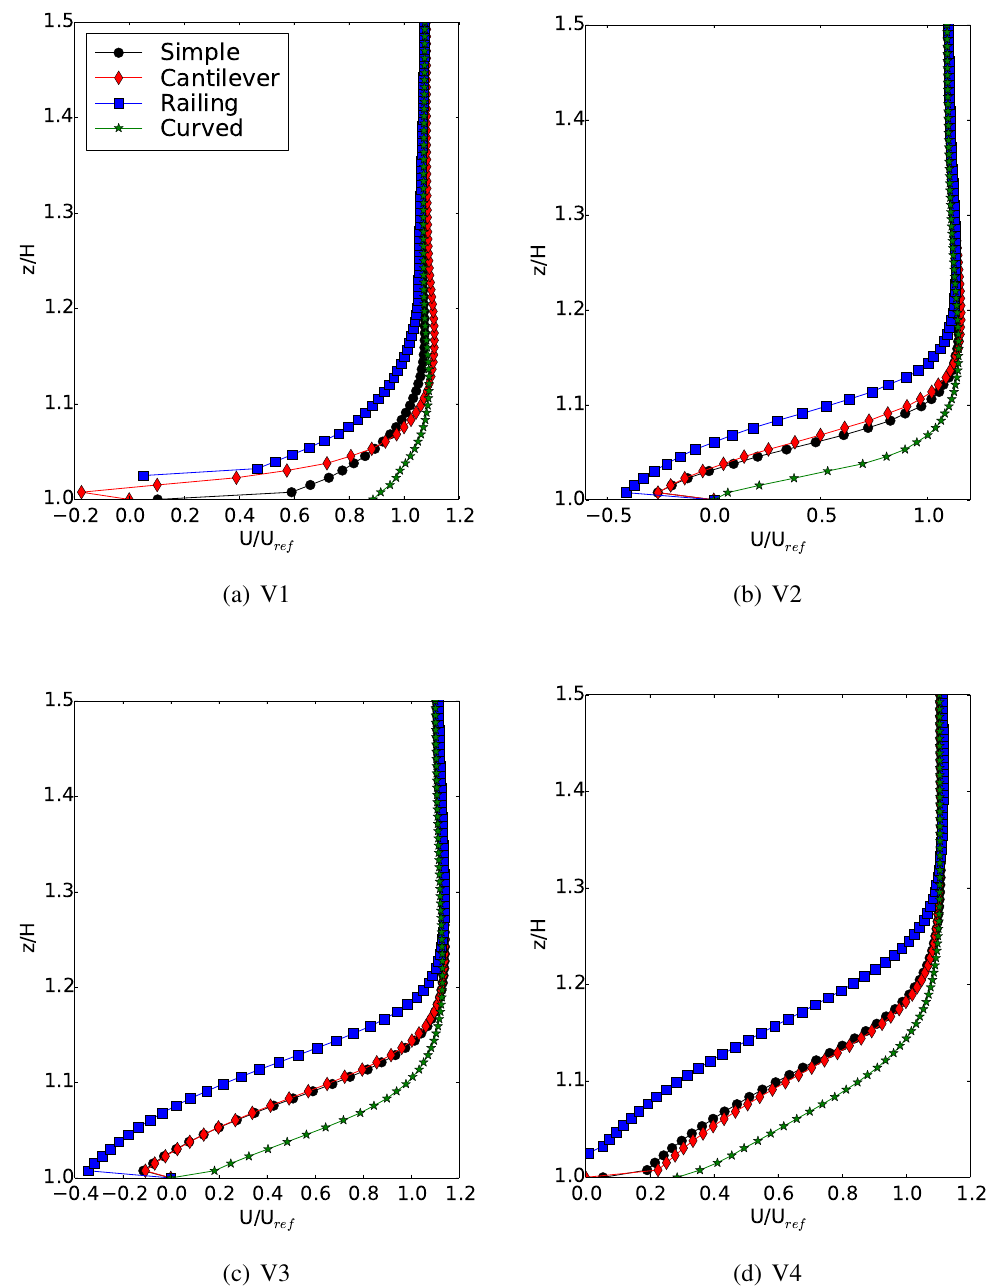
Figure 18. Comparison of U between the roof edge shapes investigated at the axes